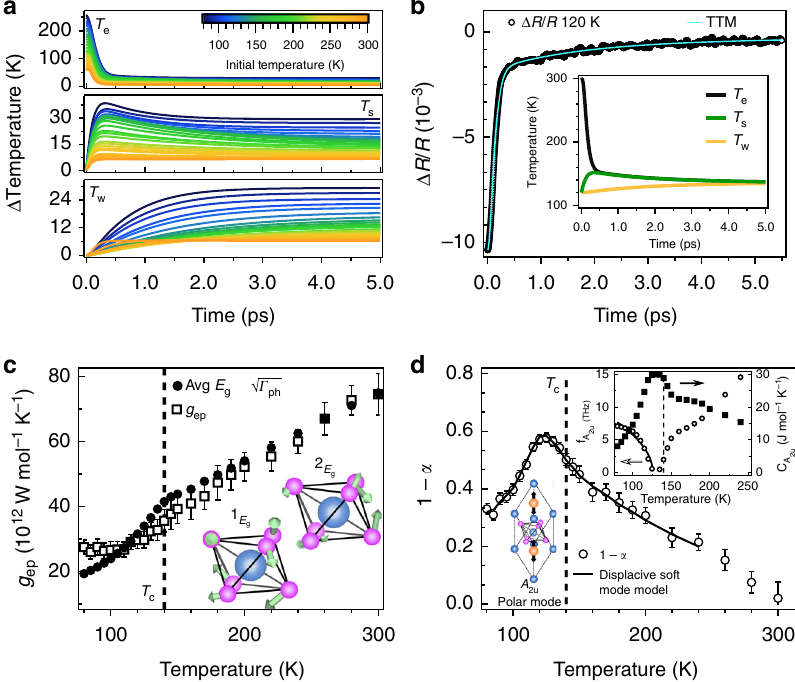
Fig. 4 Identi fi cation of the strongly and weakly coupled phonons. a Transient changes in the electronic ( T e ), strongly coupled phonon ( T s ), and weakly coupled phonon ( T w ) temperatures as extracted from a three-temperature thermalization model (TTM) of the relaxation dynamics of LiOsO 3 . Color scale represents different initial experiment temperatures before the pump pulse arrives. b Representative fi t of an experimental re fl ectivity transient at an initial temperature of T = 120 K (black circles) produced by the TTM (teal line). Inset: transient temperatures T e , T s , and T w from which the model re fl ectivity transient is generated. c Comparison of the extracted electron – phonon coupling function g ep with an average of the square roots of the 1 E g and 2 E g phonon linewidths Γ ph as reported by Raman spectroscopy 12 , suggesting these modes are strongly coupled phonons. Inset: Real space distortions of these modes with blue and pink spheres representing Os and O atoms respectively. d Temperature dependence of the heat capacity of the weakly coupled phonons represented by 1 − α . The dashed vertical line denotes the reported value of T c 8 . The solid black line is a fi t to a model where this heat capacity is attributed to a displacive A 2u polar mode (lower inset) that softens and hardens across the polar transition. Upper inset: Resonant frequency f (open circles) and A 2 u heat capacity C (closed squares) of the polar mode extracted from the displacive soft mode model. The solid black line is a fi t of the resonant frequency ffiffiffiffiffiffiffiffiffiffiffiffiffiffiffiffiffi p A 2 u in the polar phase to the Cochran relation 27 hf / 1 (cid:2) T = T expected of polar soft modes, in which T c was shifted to coincide with the peak of 1 - α at T c = c 125 K. All error bars derive from the χ 2 of the three-temperature model fi